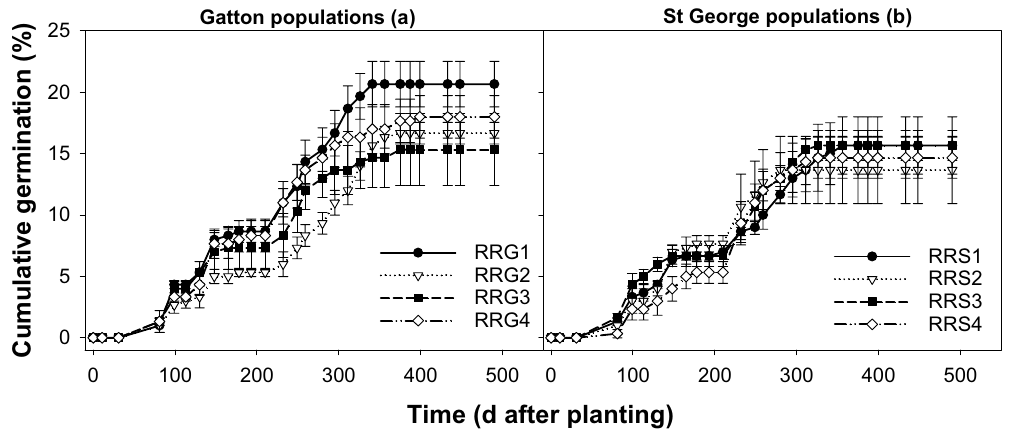
Figure 6. Emergence pattern of Rapistrum rugosum from Gatton (RRG1-RRG4; a) and St George (RRS1-RRS4; b) in trays under a rainfed environment (November 2015 to April 2017), symbols correspond to mean and error bars are the standard error of means (n =